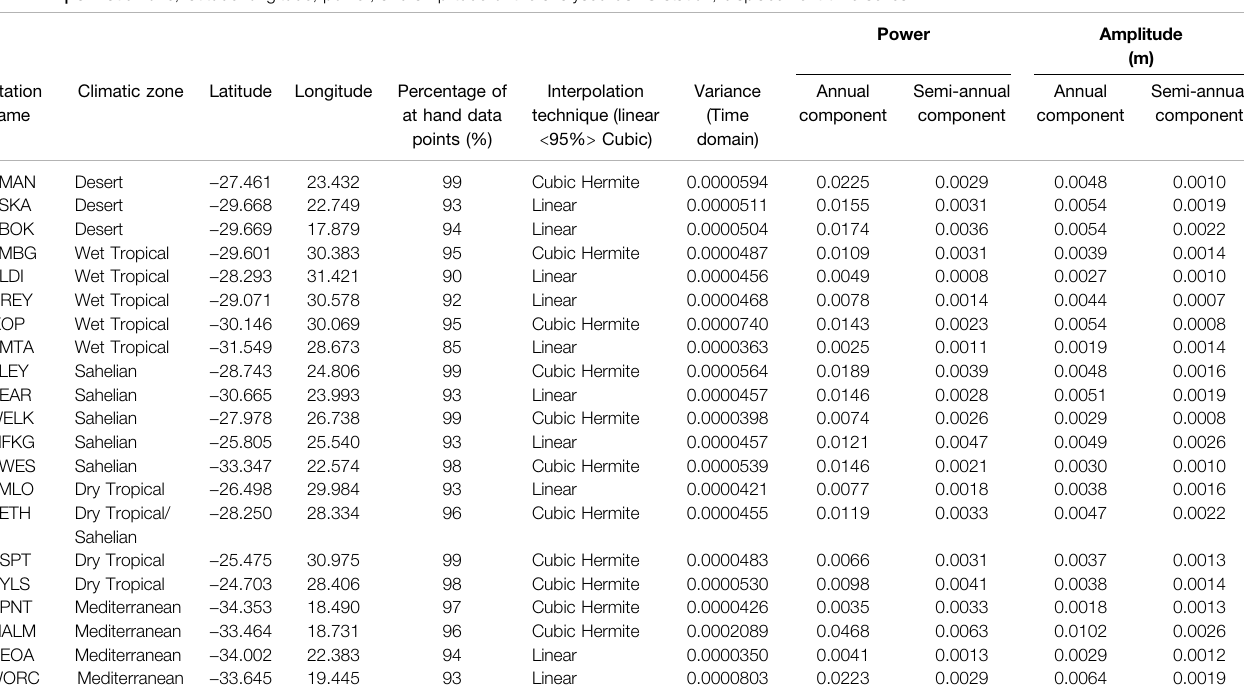
TABLE 1 | Climatic zone, latitude longitude, power, and amplitude of the analysed cGPS station, displacement time series.